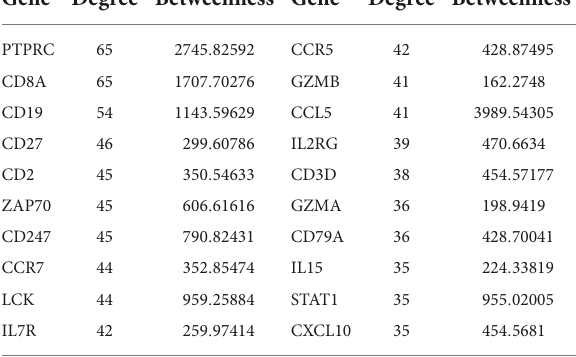
TABLE 1 Top 20 degrees genes among upregulated genes.